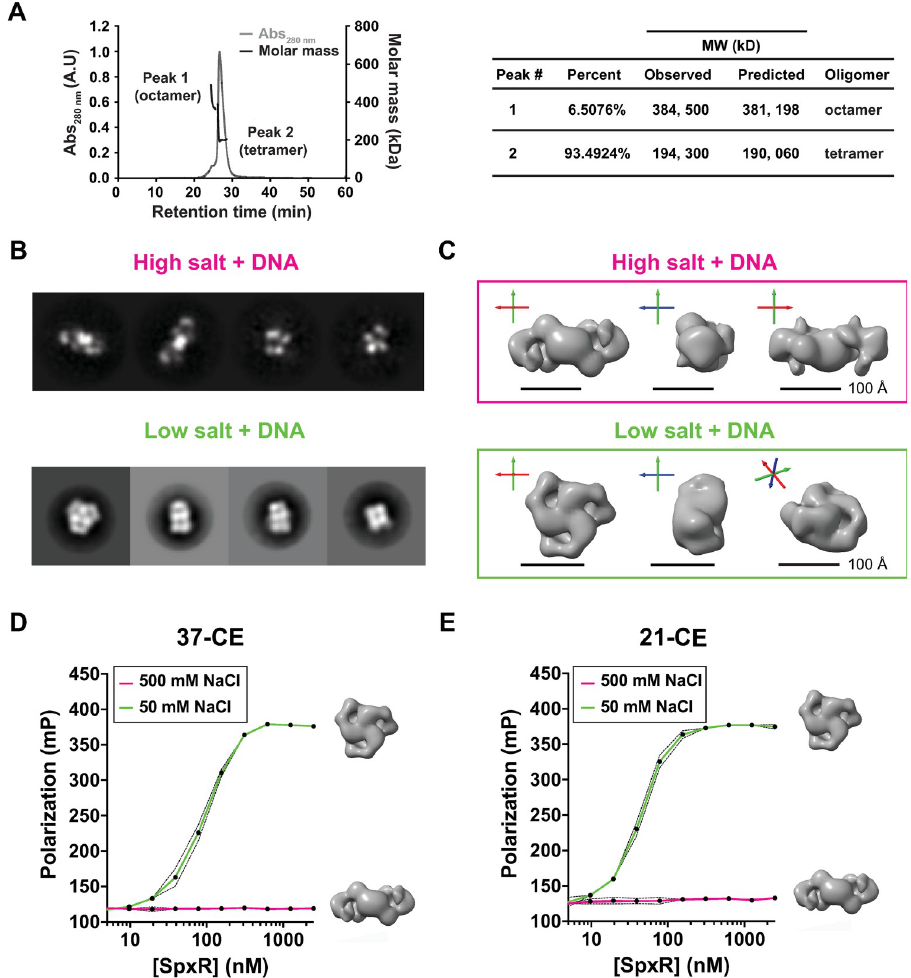
Fig 5. Quaternary structure of SpxR. ( A ) SEC-MALS analysis (left) and numeric mass data (right) of SpxR in high salt (500 mM NaCl). A major tetramer peak and a minor octamer peak were observed. ( B ) EM negative stain 2D class averages of SpxR with DNA in both high and low salt. ( C ) Low resolution 3D models for SpxR with 37-CE DNA in high salt (tetramer) and low salt (trimer “wheel”). The diagram shows three views of the complexes obtained from the EM negative stain data. The long axis of the tetramer complex (high salt) is approximately 200 Å long, whereas the diameter of the trimeric (low salt) wheel is approximately 135 Å . In the low salt complex there is a visible opening formed by the domains, which could be where the double stranded DNA resides. For reference, the three Cartesian axes are shown (X red, Y green, Z blue) on each picture. ( D ) Fluorescence polarization of SpxR titrated into either 37-CE DNA or ( E ) 21-CE DNA, in either low or high salt buffer (Tris pH 7.0 with 50 mM NaCl or 500 mM NaCl, respectively). Polarization is expressed in millipolarization units (mPs). The mean of three independent experiments is plotted. Error bars represent standard deviation and are indicated by dashed